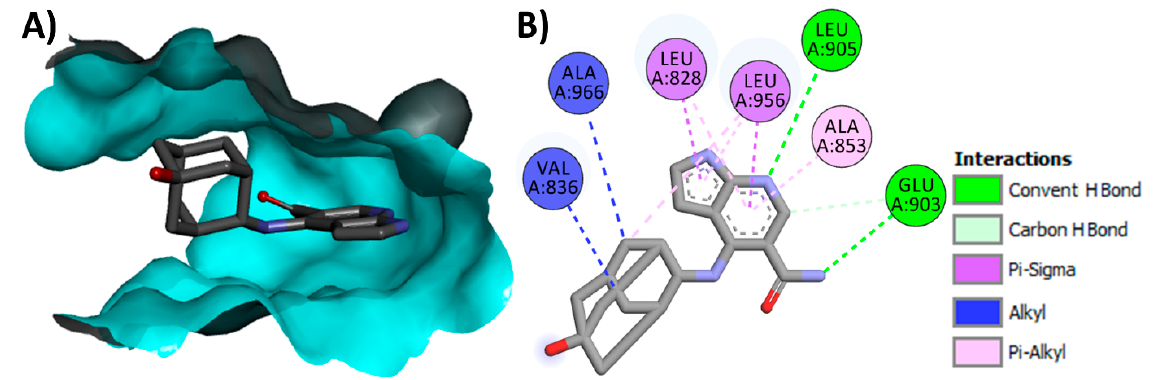
Figure 47. Binding modes of peficitinib (shown as sticks) into JAK3 (pdb: 6AAK): ( A ) 3D binding mode, receptor shown as a hydrogen bond surface; ( B ) 2D binding mode showing different types of interactions with JAK3; hydrogen atoms were omitted for clarity; this figure was generated using Discovery Studio Visualizer (V16.1.0.15350).